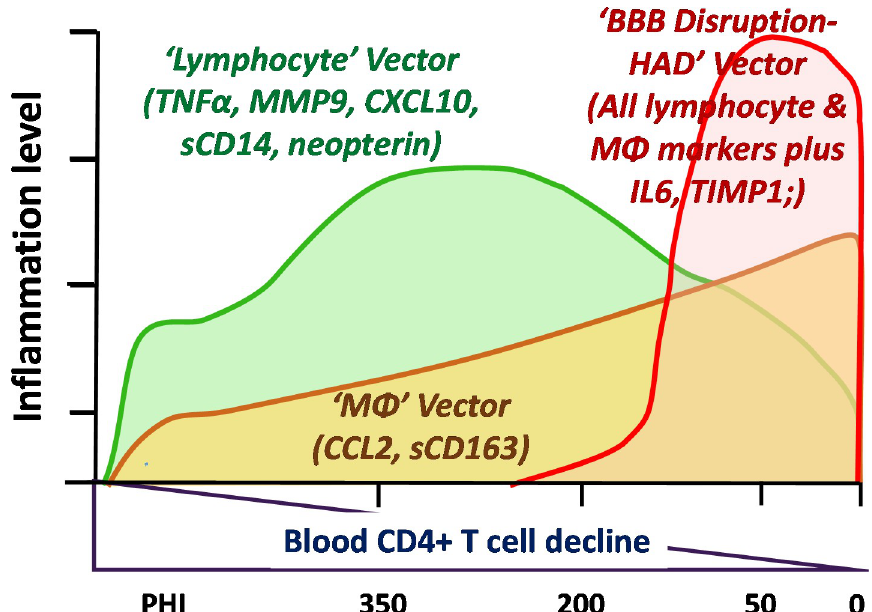
Fig 6. Model of evolving CNS inflammation with systemic and CNS disease progression. This simplified diagram outlines a model of the changes in three components, here referred to as ‘vectors’, of CSF inflammation identified in this study. Because of the variability and relatively small sample, these are not precisely mapped but only roughly outlined to provide a general conceptual framework. The lymphocyte vector develops during primary infection, increases as blood CD4+ T cells decline to reach a peak in the middle range of blood CD4+ T-cell counts (centered at 200–350 cells/ μ L), and then falls as these counts decline further, eventually to levels near normal when the blood CD4 + levels are below 50 cells/ μ L. This pattern is defined by the quadratic pattern in trends analysis and prominently includes the CSF markers listed in the figure. Importantly, it is also the pattern of CSF WBCs and HIV-1 RNA. The second pattern, the ‘macrophage’ (M F ) vector, involves a gradual increase in CSF biomarker concentrations with falling blood CD4+ T-cell count. It includes the CSF markers with linear pattern listed in the figure along with a component of CSF MMP-9 and perhaps CSF neopterin. This is also the pattern of CSF NfL concentrations, and thus at a certain threshold this vector appears to associate with the ‘noninflammatory’ type of CNS injury. The third vector includes the disruption of the blood-brain barrier and increased concentrations of all the inflammatory markers in HAD. The cause of this disruptive increase in the barrier is not certain but it associates not only with an increase in all CSF biomarkers, but with more severe CNS injury, higher CSF NfL and elevated levels of CSF